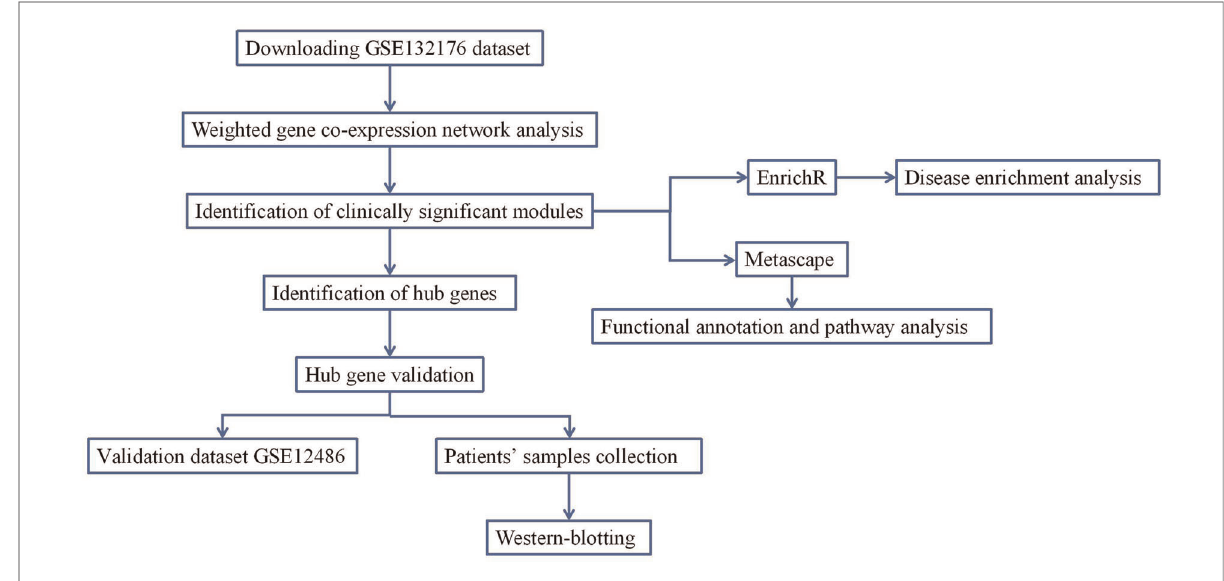
FIGURE 1 The work fl ow of data preparation, processing, analysis and